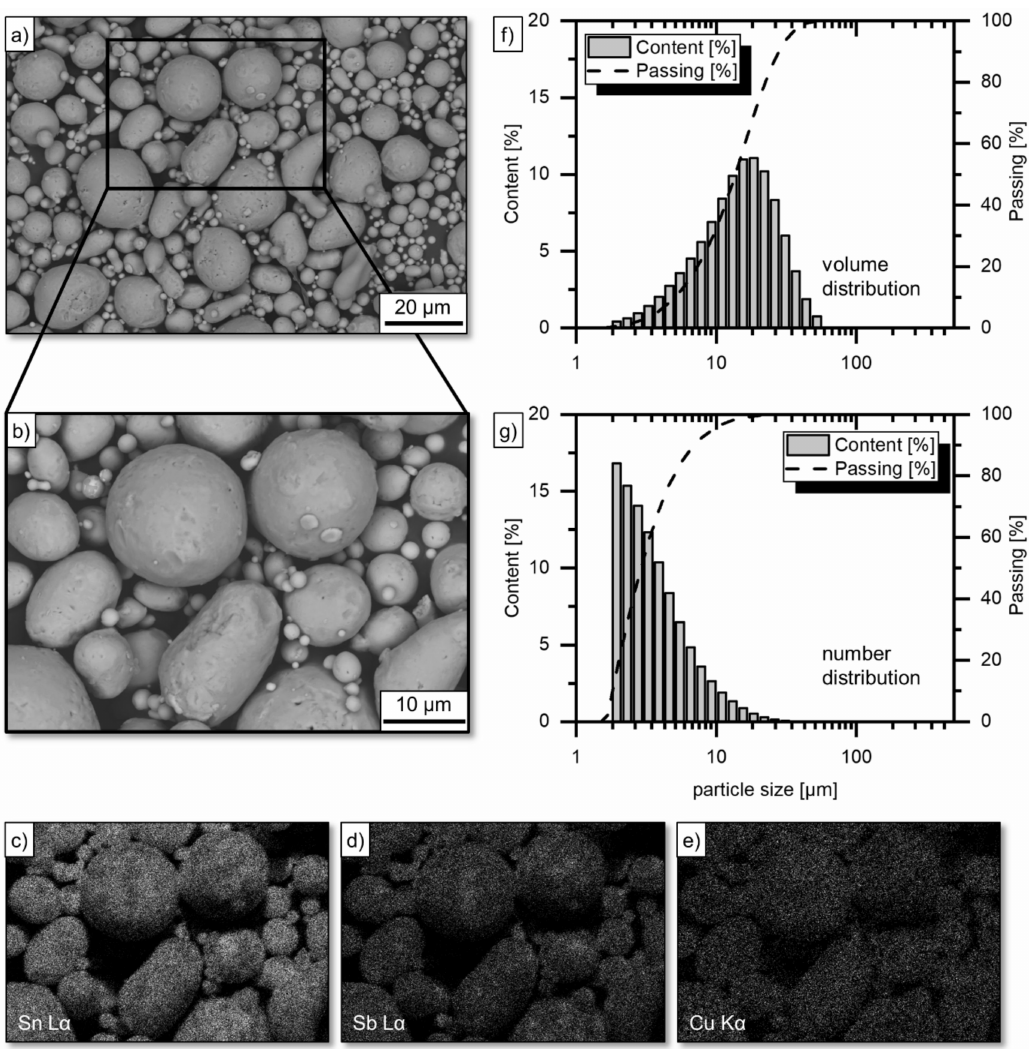
Figure 1. ( a–e ) SEM images and corresponding EDS maps obtained from Cu K α , Sn L α and Sb L α showing the morphologies of the di ff erent powder particles and the distribution of element concentrations; ( f , g ) the charts illustrate the volume and number of particle size